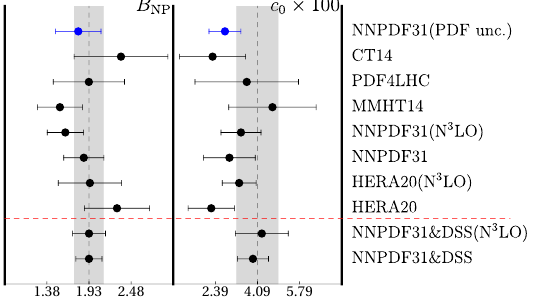
Figure 6 . Comparison of NP parameter for TMD evolution extracted in di(cid:11)erent (cid:12)ts. The values above the red-dashed line are extracted in (cid:12)t of DY data, see table 5. The values below the red- dashed line are extracted in global (cid:12)t of DY and SIDIS data, see table 9. The vertical dashed lines and gray boxes correspond to average mean and standard deviation of the results of the global (cid:12)t. The blue points and their error-bars correspond to the estimation of the uncertainties from the collinear PDF (see section 5.3). The input collinear distributions are marked in the right column.